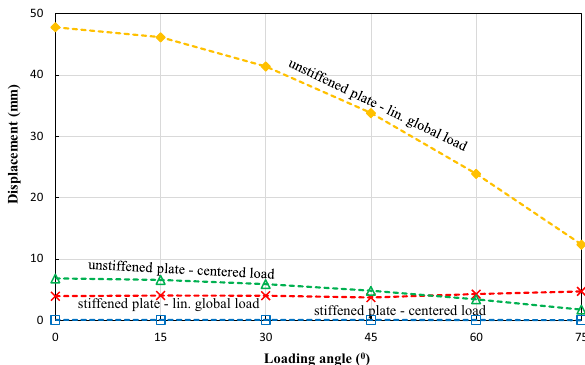
Figure 8: Maximum displacement value of sti ff ened and unsti ff ened low - carbon steel materials.